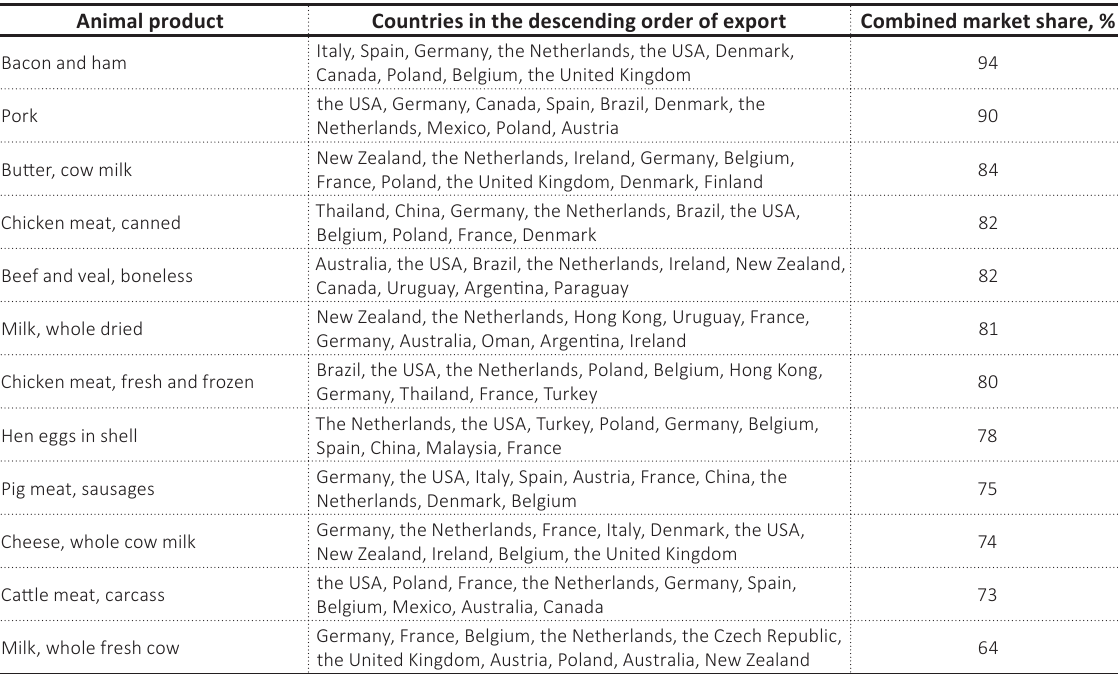
Source: Composed by the authors.